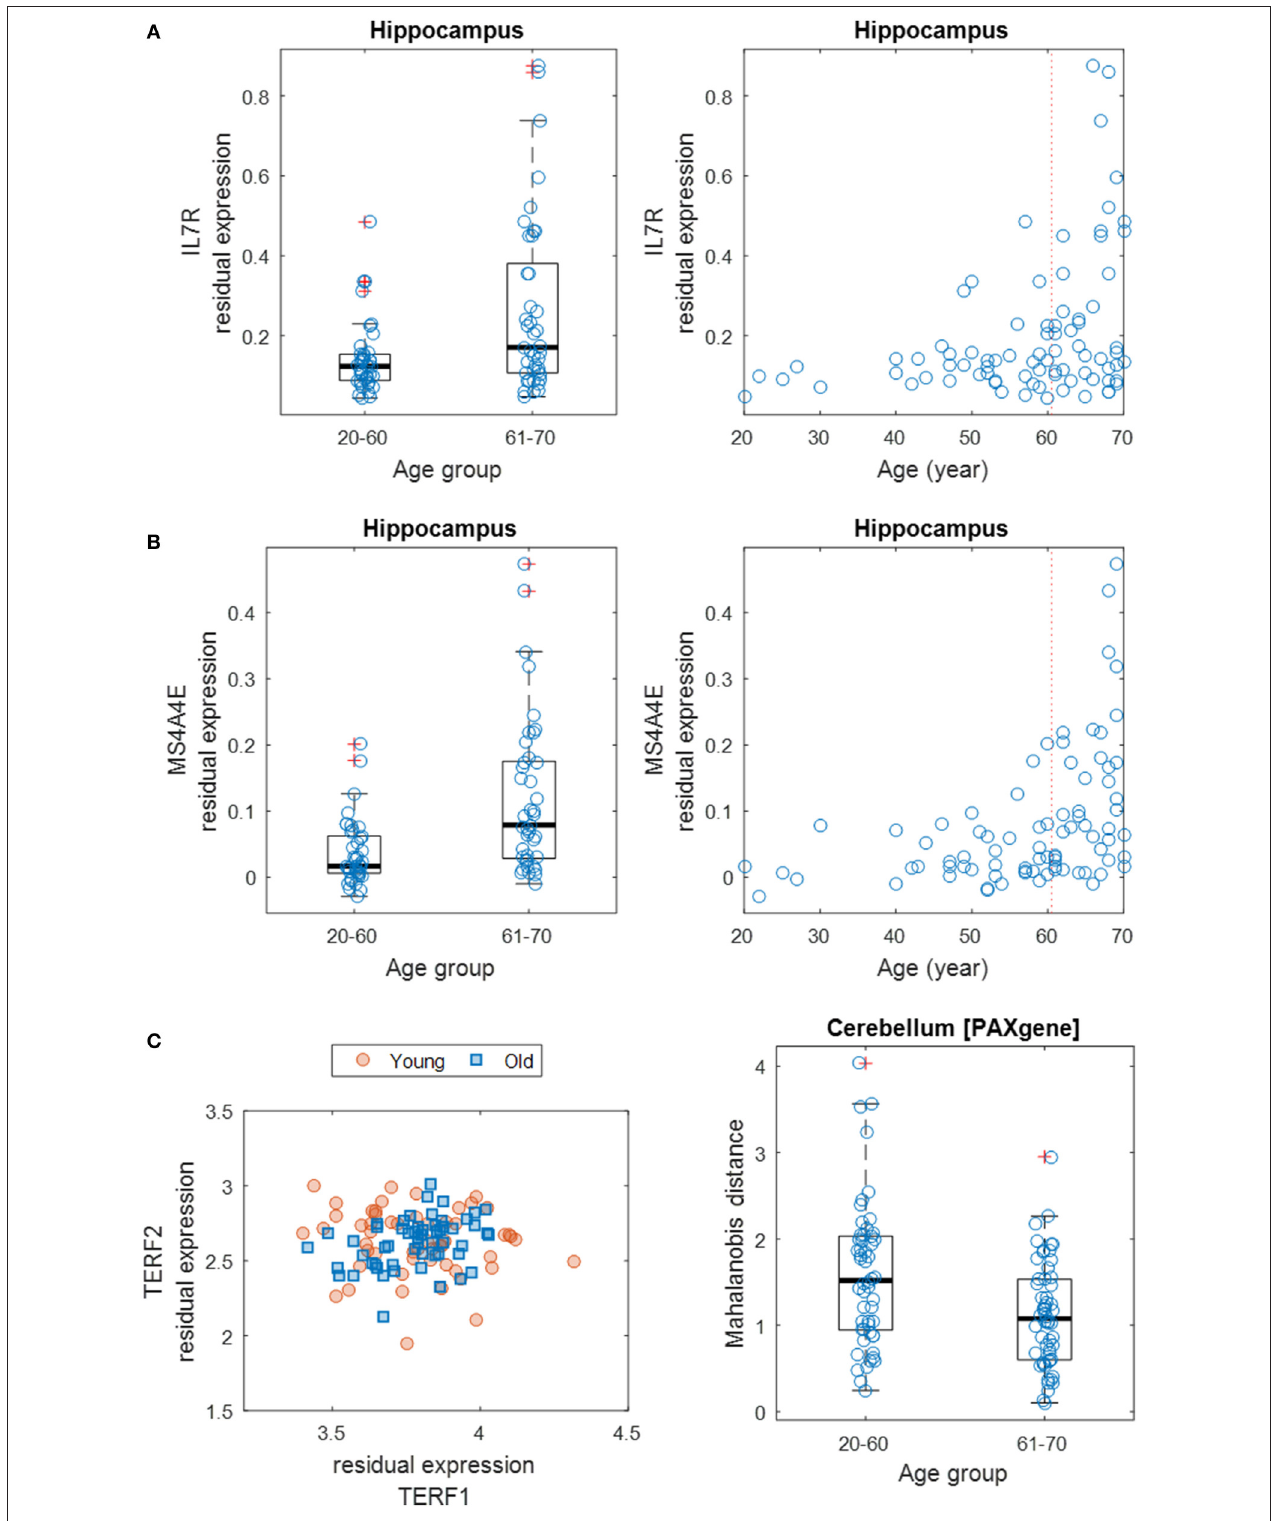
FIGURE 4 | Differential gene expression dispersion between age groups. (A) Increased gene expression variance of IL7R in hippocampus between age groups (left: 20–60 years vs. 61–70 years; right: all ages). Each age group was plotted with jitter along the x-axis to show samples within each genotype. (B) Same as (A) but for MS4A4E . (C) Scatter plot (left) of expression levels of TERF1 and TERF2 with data points grouped by young (20–59 years) and old (60–70 years) ages. Boxplot (right) of MDs of young and old samples’ TERF1 and TERF2 expression profiles to the population center.